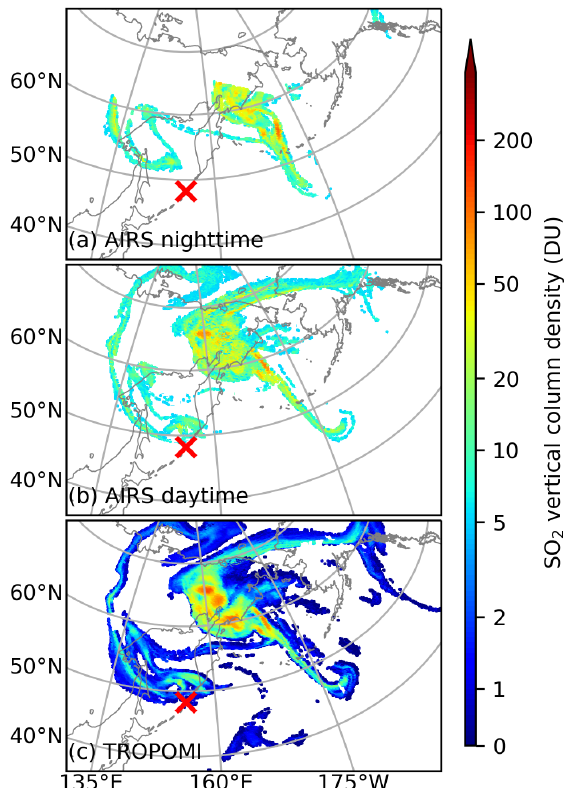
Figure 2. Spatial distribution of SO 2 vertical column density (DU) during the 24h period between 26 June 2019, 12:00UTC, and 27 June 2019, 12:00UTC, from AIRS nighttime (a) , AIRS day- time (b) , and TROPOMI daytime (c) retrievals. Note that AIRS retrievals of SO 2 vertical column density less than 5DU are not shown here as those data are not actually used in the analysis be- cause they are affected by background noise. The AIRS nighttime retrievals have a ∼ 12h time shift compared with the AIRS daytime and TROPOMI